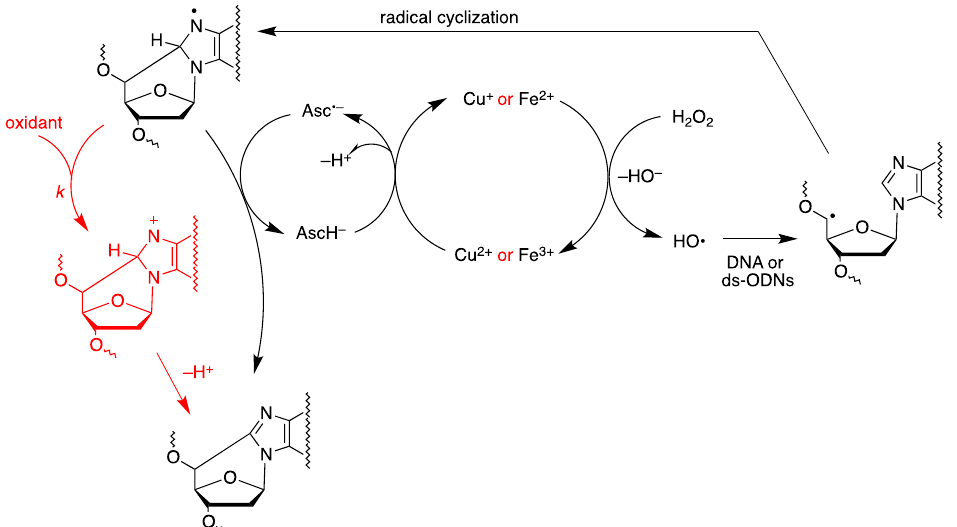
Figure 15. The conceived reaction mechanism for the formation of cPu lesion in ds-ODNs by Fenton-type reactions.